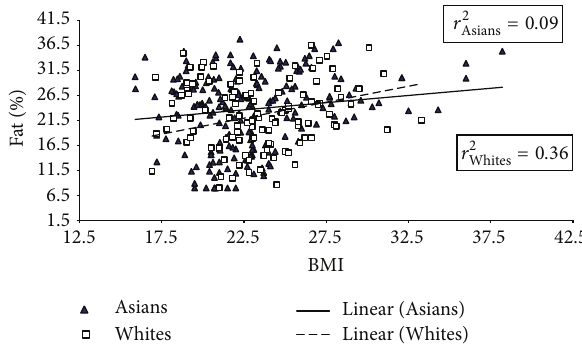
Figure 1: Distribution of body-mass index and percentage body fat for males according to race/ethnicity.